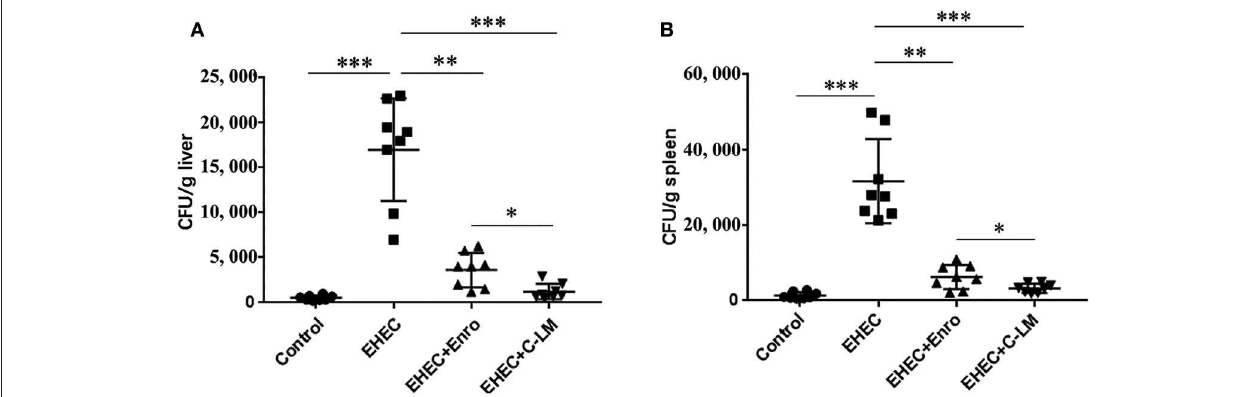
FIGURE 8 | Improvement of host defense against EHEC infection by C-L. The number of bacterial CFUs transferred to the liver (A) and spleen (B) on day 3 after infection are shown. The control group was orally administered 100 µ L sterile PBS; the EHEC group was orally administered 100 µ L sterile PBS containing 1 × 10 8 CFUs EHEC O157:H7; the EHEC + Enro and EHEC + C-LM groups were administered 100 µ L sterile PBS containing 1 × 10 8 CFUs EHEC O157:H7 and then treated by i.p. injection with 8 mg/kg Enro and C-L, respectively, once/day for 3 days. The data are shown as the mean ± standard deviation ( n = 5). NS, P > 0.05; * P ≤ 0.05; ** P ≤ 0.01; *** P ≤